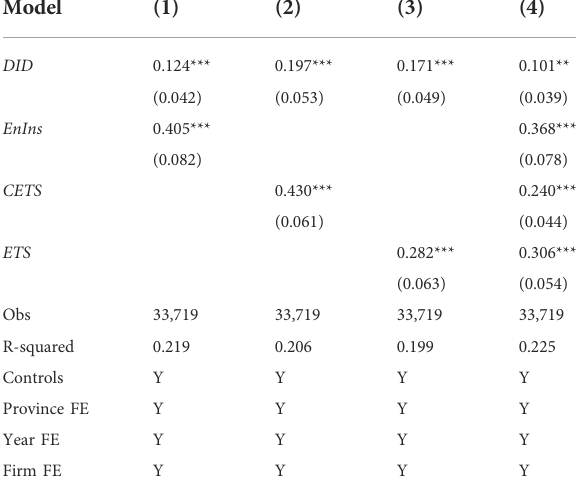
TABLE 4 DDD estmation result. Model